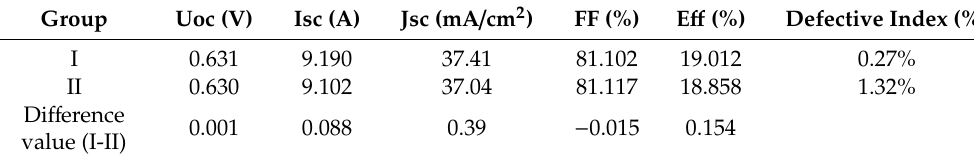
Figure 6. The appearance comparison diagram of black silicon cells. Table 3. The electrical performance results for di ff erent groups.